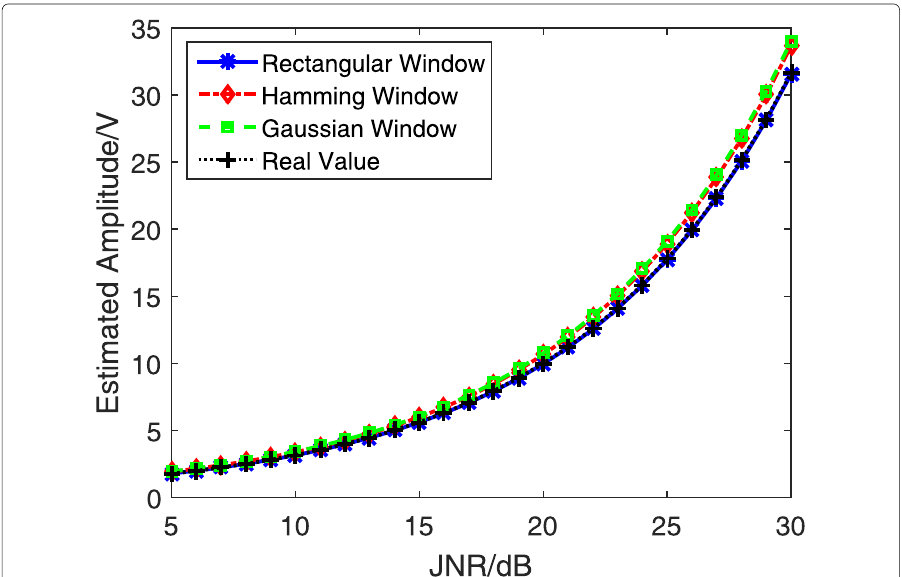
Fig. 7 Estimated value of jamming signal using STFT with different window